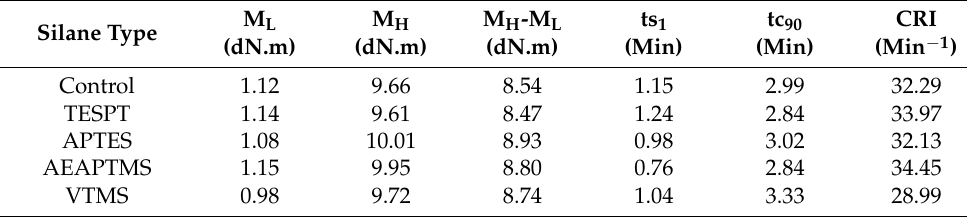
Figure 2. Rheometric curves of NR/HNT composites filled with and without silane coupling agents. Table 2. Raw data extracted from the rheometric curves of NR/HNT composites filled with and without silane coupling